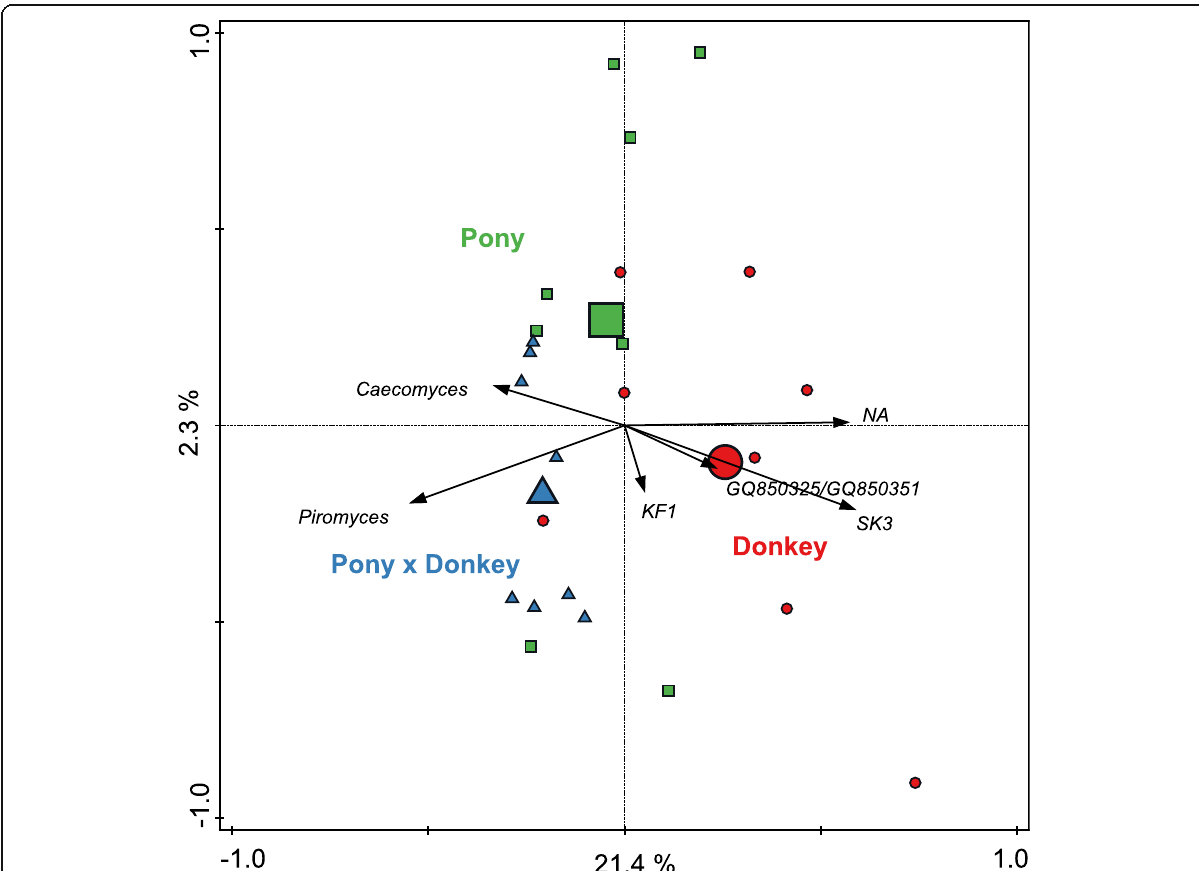
Fig. 5 Redundancy analysis triplot showing the relationship between the anaerobic fungal genus-level phylogenetic groupings of the OTUs for which the variation is best explained by the constrained axes. Arrow length indicates the variance that can be explained by equine type, with the perpendicular distance of the equine types to the arrow indicating the relative abundance of the genus-level phylogenetic grouping. Arrow labels indicate the taxonomic affiliation that the genera could be reliably assigned to. For example, ‘ g_SK3 ’ represents a grouping reliably assigned to the SK3 genus, whereas ‘ NA ’ indicates that it was reliably assigned to the family Neocallimastigaceae but the genus could not be annotated. Equine type means (large symbols) and individual samples (small symbols) are coded by equine type: donkey (red circle), pony (green square) and pony × donkey (blue triangle). Equine type explained 23.6% of the total variation in the dataset, and the plot axes are labelled